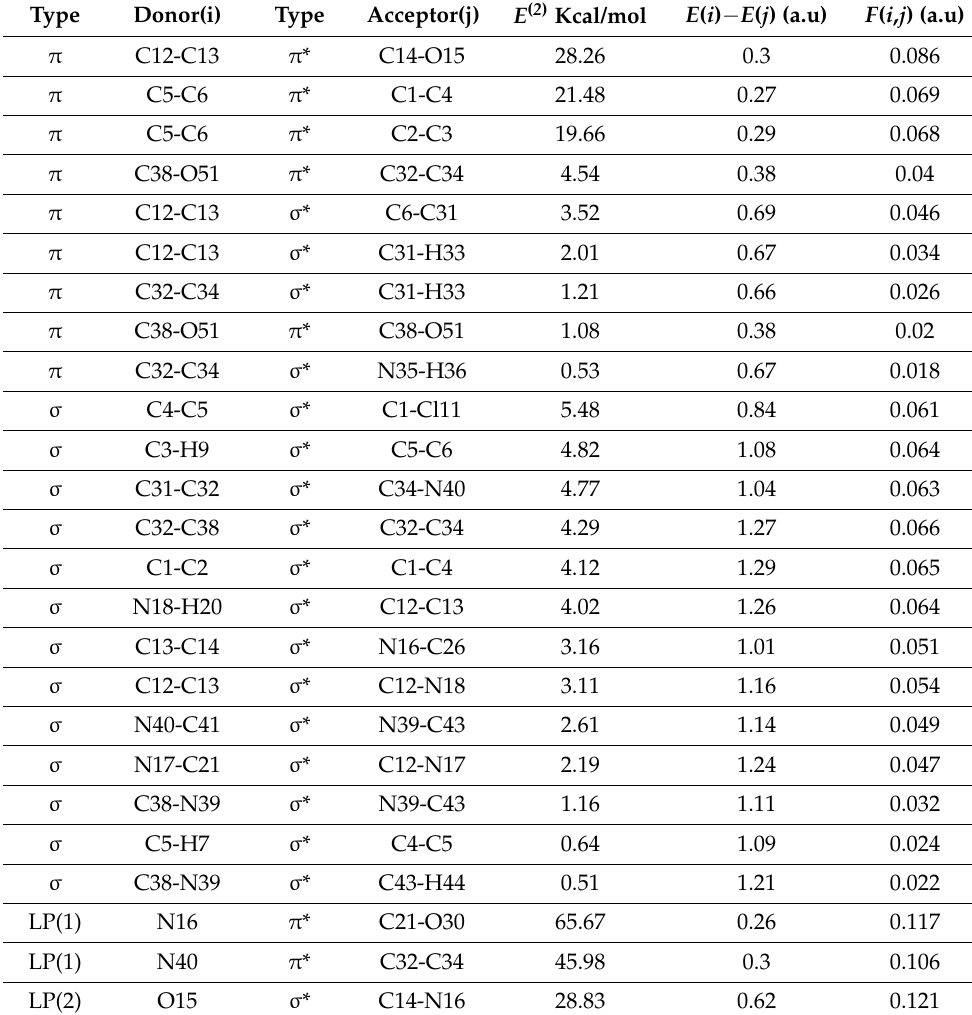
Table 3. Second-order perturbation theory analysis of Fock matrix as a basis for the NBO analysis between donor and acceptor orbitals of the studied